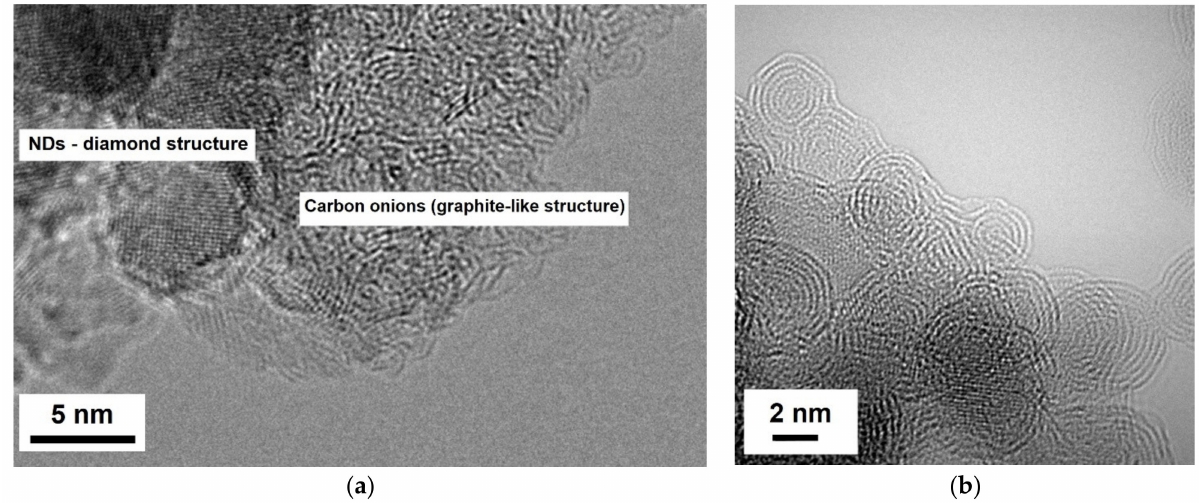
Figure 6. TEM images of nanodiamonds after annealing at 1200 ◦ C: ( a ) fracture of ND agglomerate after partial transforma- tion; and ( b ) complete transformation of ND in surface layers of